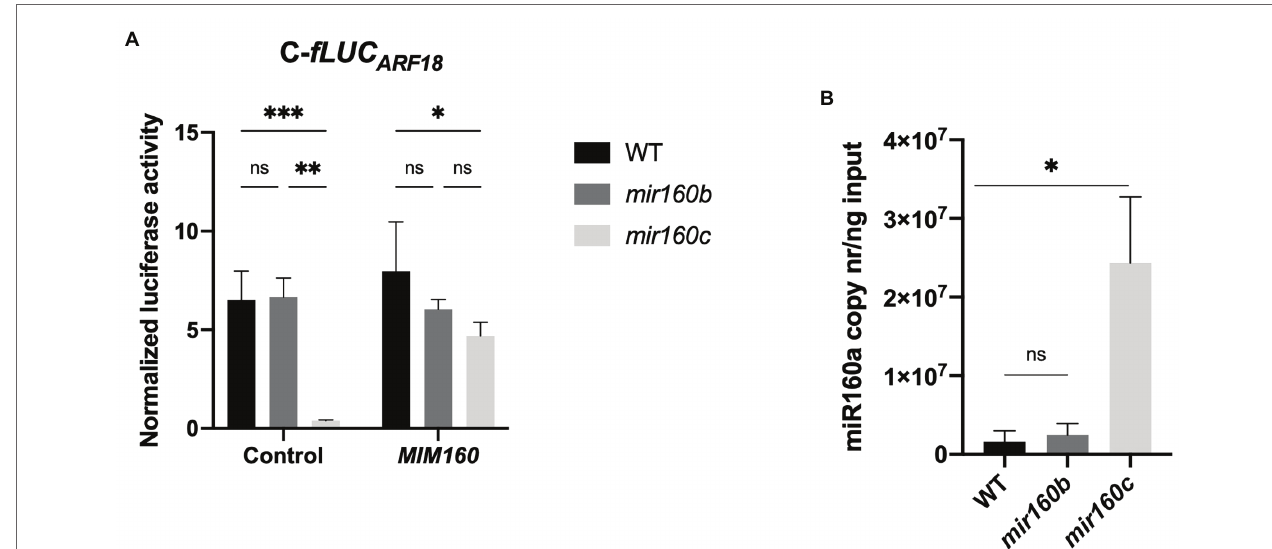
FIGURE 3 | Different levels of ath-miR160a activity in mir160b and mir160c Arabidopsis protoplasts. (A) Normalized luciferase activity of cleavable (C- fLUC ARF18 ) reporter for ath-miR160a activity in wild-type (WT), mir160b and mir160c Arabidopsis protoplasts in the presence of the indicated elements. Bars represent mean ± SE of at least two independent experiments with two technical replicates each. Asterisks (*) represent significant differences according to p value classification ( p < 0.05) obtained by two-way ANOVA and Tukey’s multiple comparison test. (B) Absolute quantification of miR160a copy number in WT vs. mir160b and mir160c Arabidopsis . Bars represent mean ± SD of three biological replicates. Asterisks (*) represent significant differences ( p < 0.05) obtained by an unpaired t -test comparing each mutant to WT. ns, non-significant.